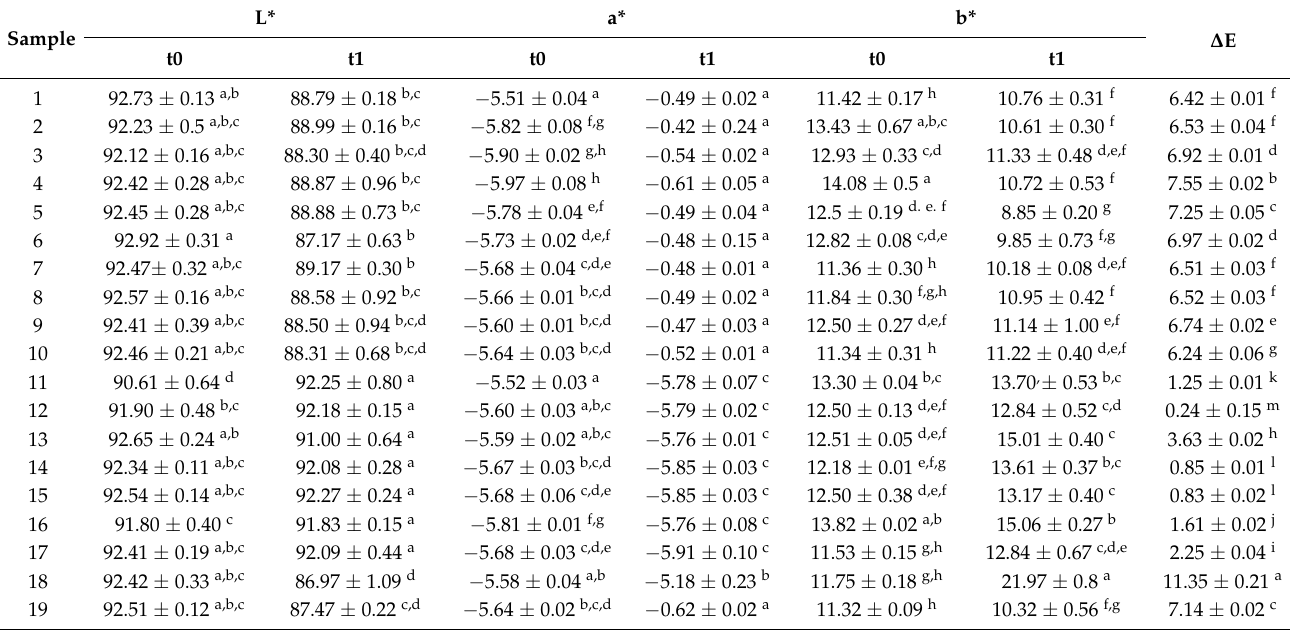
Table 2. Evaluation of color parameters before (t0) and after storage